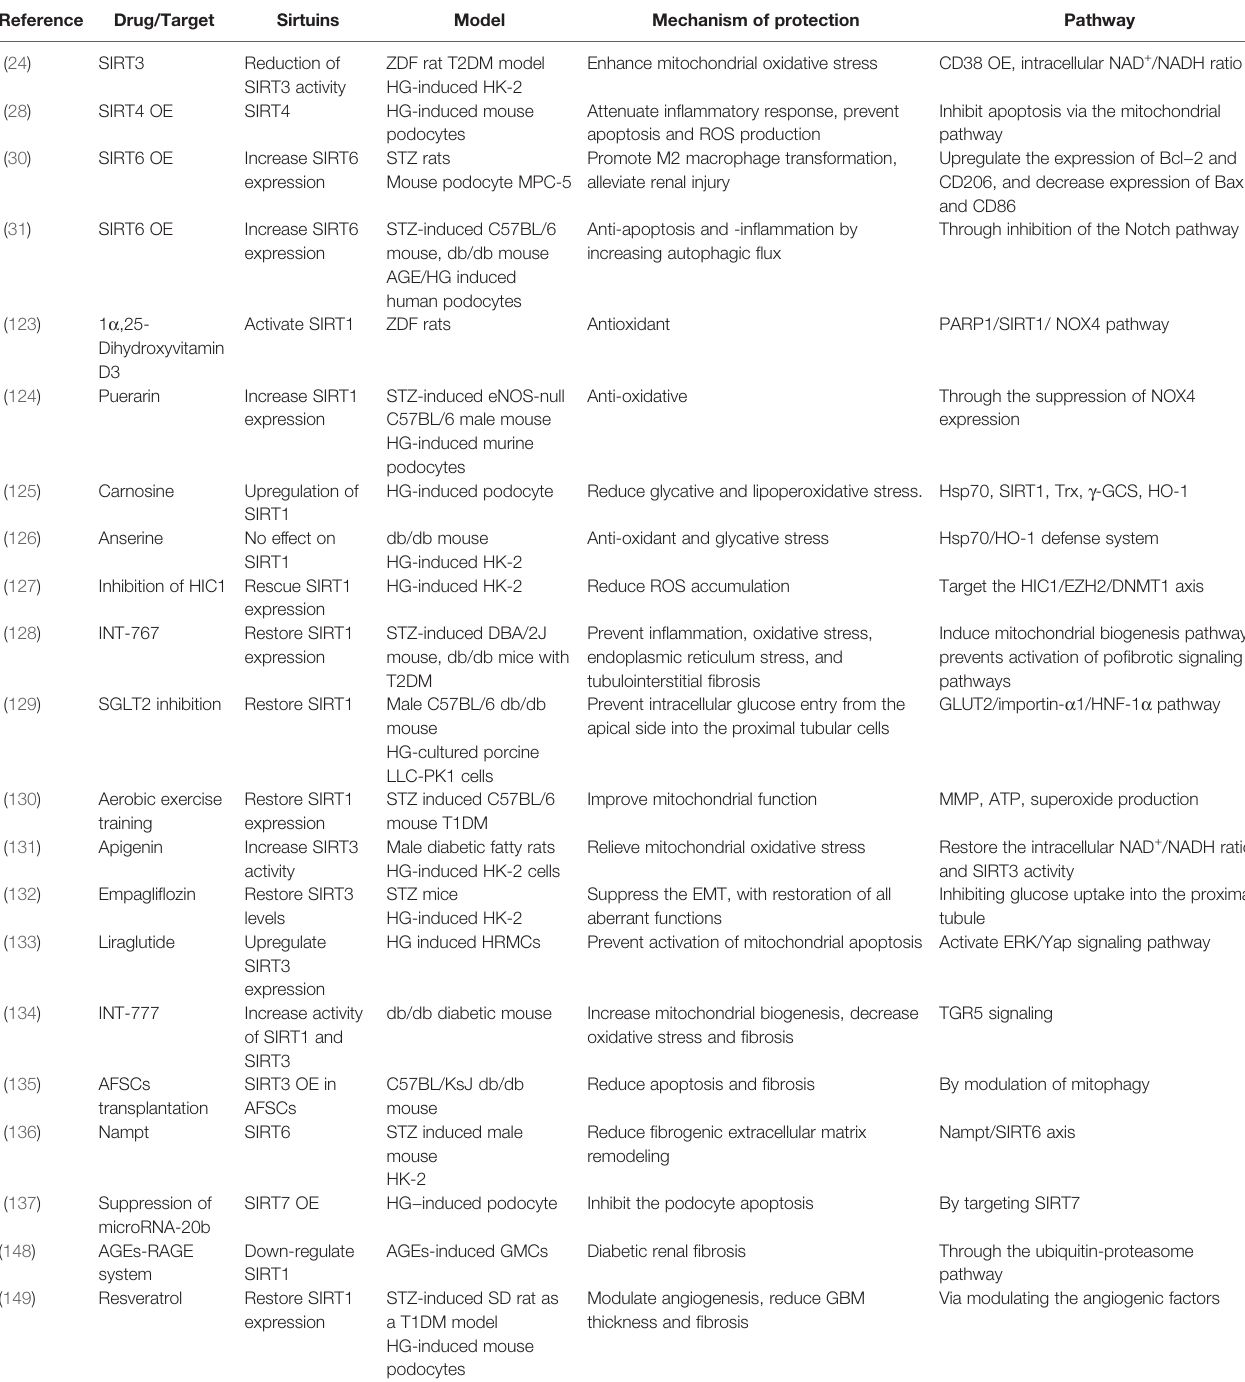
TABLE 9 | DKD studied on other